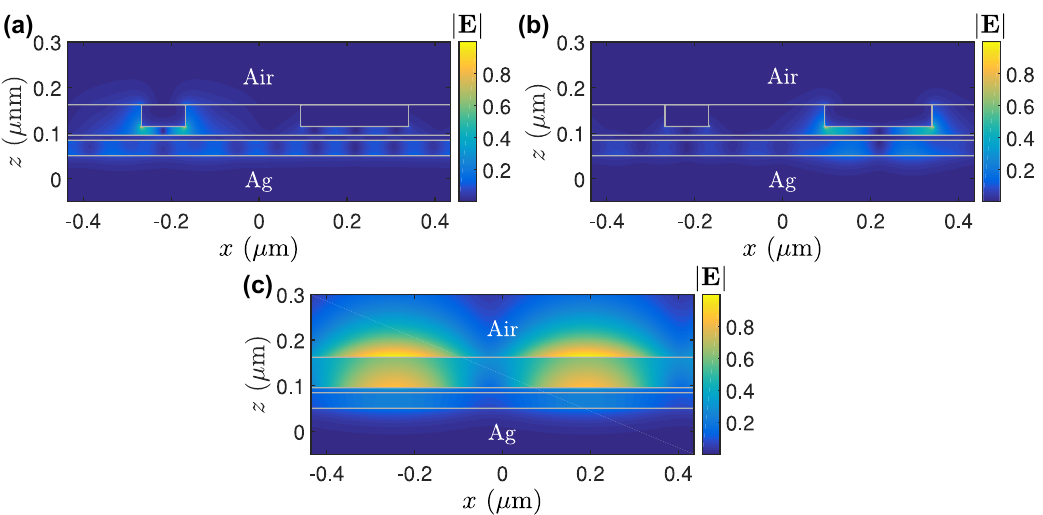
] = 2.192513, a quasibound Figure 7: Modal electric field (magnitude) of the eigenmode sustained in the 2D structure with (a) Re[ N eff ] = 2.864253, a bound supermode excited by the i = ± 4 order (see Table 2). supermode excited by the i = ± 3 diffracted orders and (b) Re[ N eff The field shown in (c) is the leaky SP mode with Re[ N ] = 1.453872 of the same 2D structure as in (a) and (b) but deprived of the Al strips. eff Table 3: Comparison of normalized parallel wave vectors k x ∕ k 0 associated with the first six diffracted orders and modal indexes of the supermodes sustained by the 2D structure sliced along the cell diagonal passing prisms 1 and 3 at 𝜆 0 = 627 nm. The corresponding effective strip widths are 156.42 and 164.31 nm,